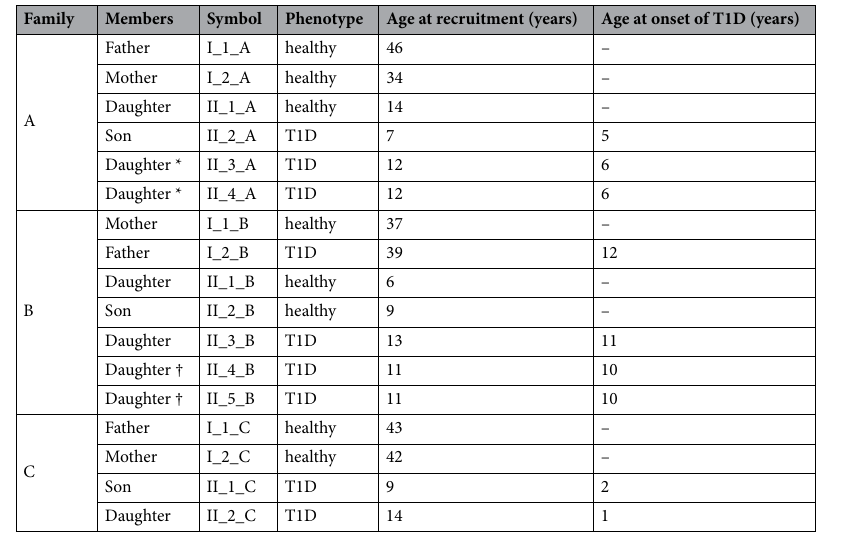
Table 1. Clinical characteristics of the study cohort. Twins; dizygotic *, monozygotic